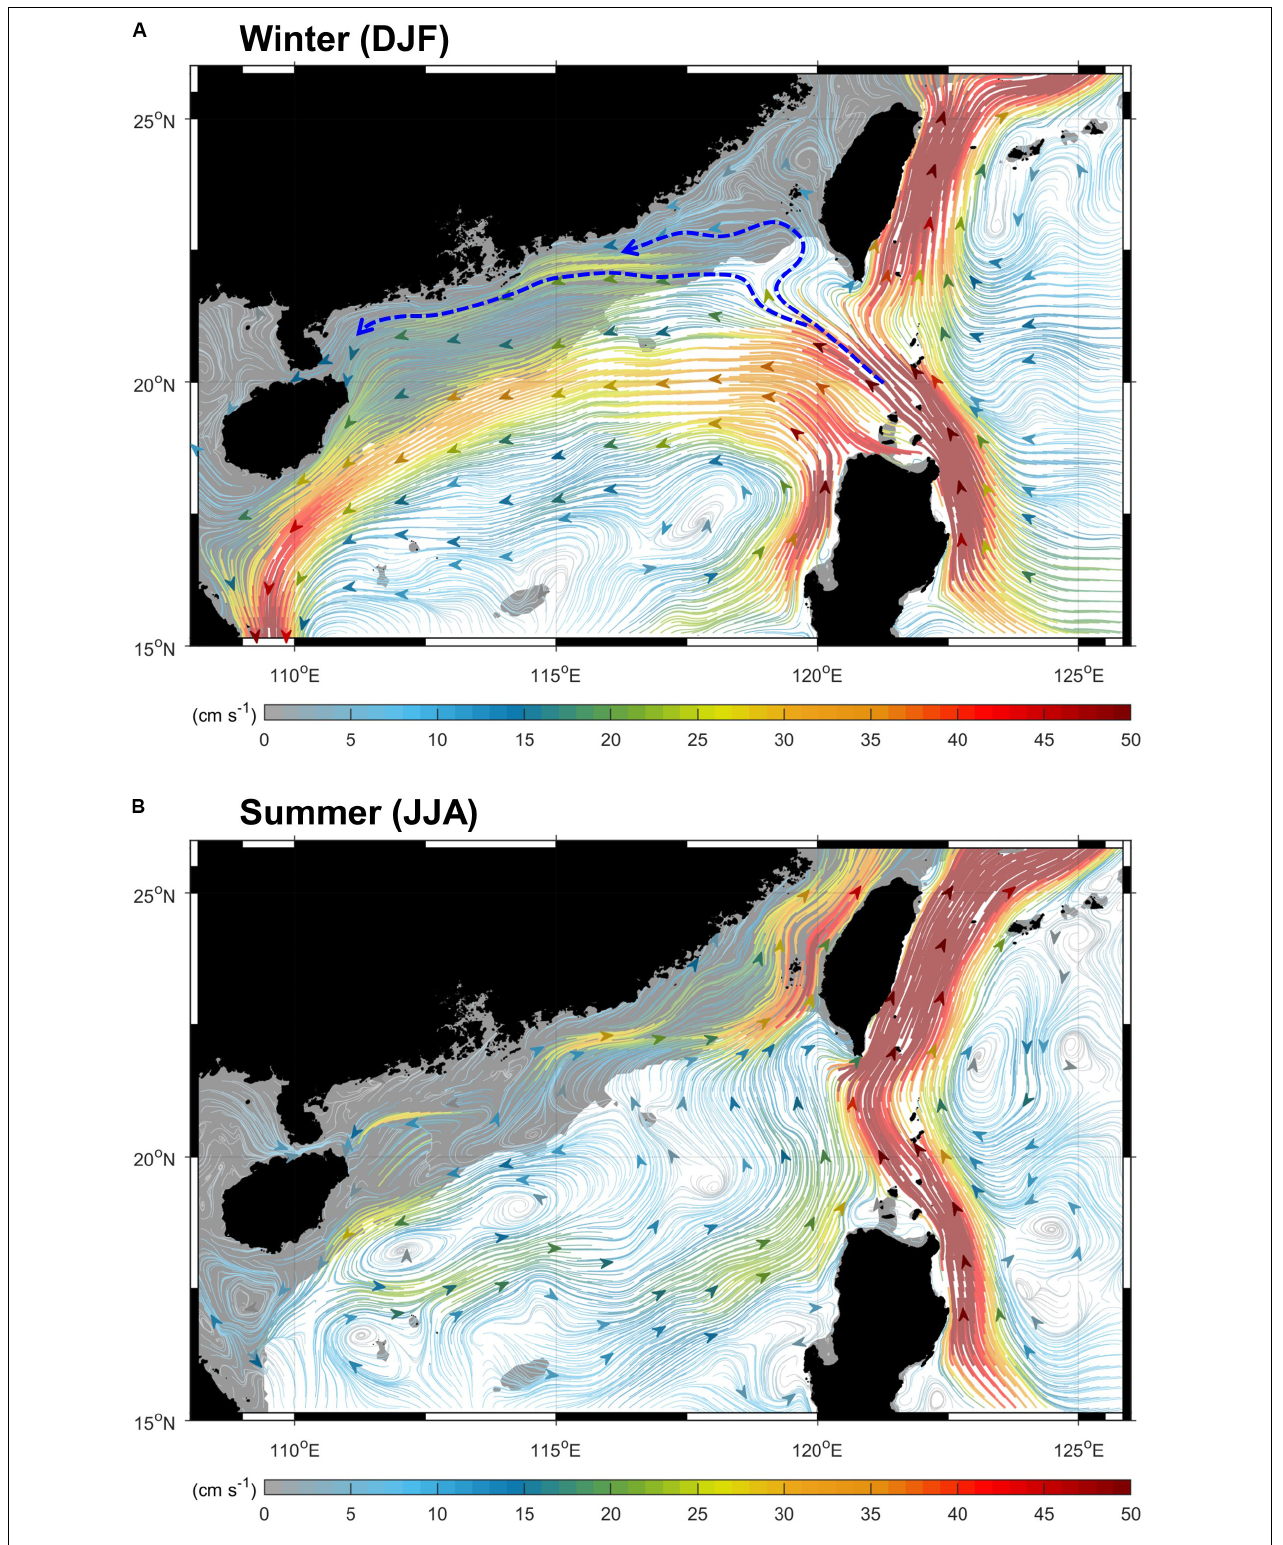
FIGURE 7 | Mean surface currents (15 m depth) of (A) winter and (B) summer in the study area over 1993–2019, obtained from the GDP and 1/12 ◦ global reanalysis databases. The color shows the speed, and the shaded areas refer to the regions of continental shelves (depth < 200 m). Two dashed lines and arrows indicate two pathways that the intruded Kuroshio could directly reach the nSCS and SM18.